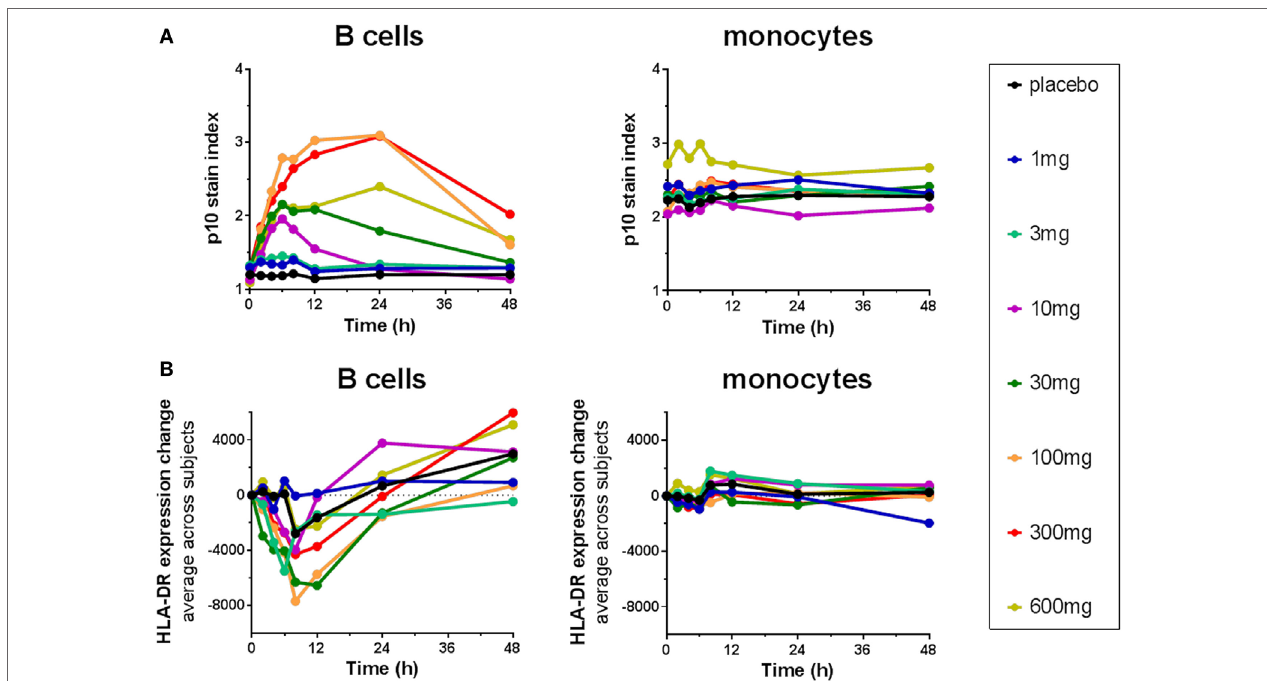
FIgURe 6 | Cathepsin S inhibitor RO5459072 induced Lip10 accumulation and major histocompatibility complex class II expression reduction in B cells but not monocytes of healthy volunteers. Healthy volunteers enrolled in a single ascending dose clinical study of RO5459072 were given a single oral dose of the cathepsin S inhibitor ranging from 1 to 600 mg or a placebo control. Intracellular p10 stain index (A) and HLA-DR surface expression (B) were measured in circulating B cells and monocytes from PBMC enriched from whole blood samples taken at baseline (0 h) and after administration of the inhibitor or placebo (2–48 h). Data represent averages of six subjects per treatment